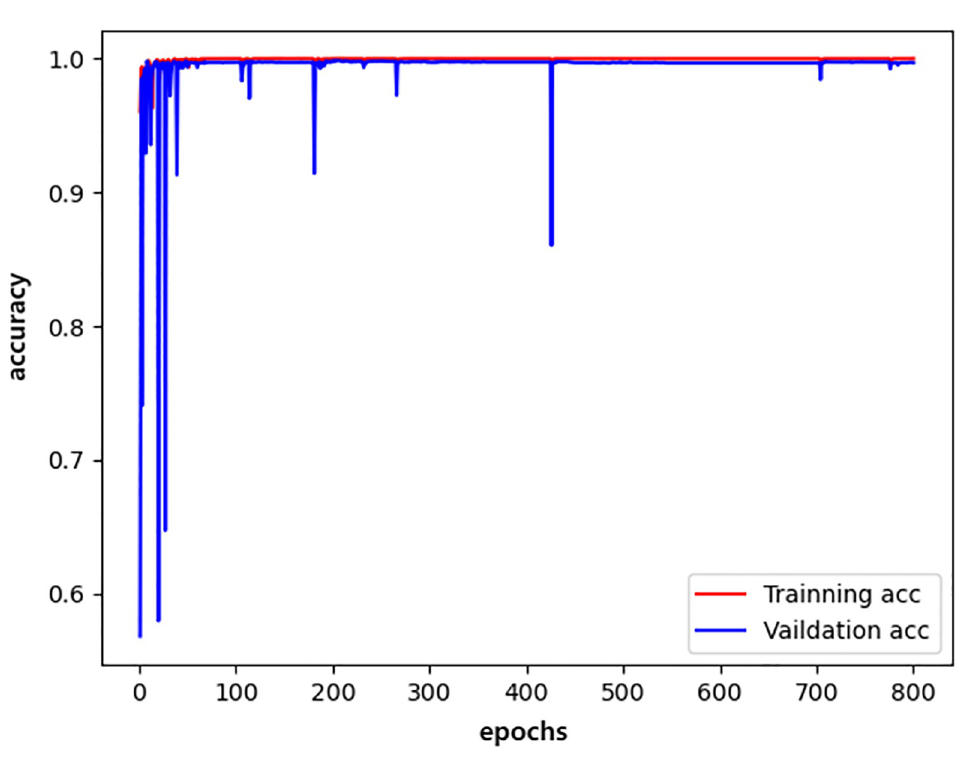
Fig 11. resnet_accuracy.